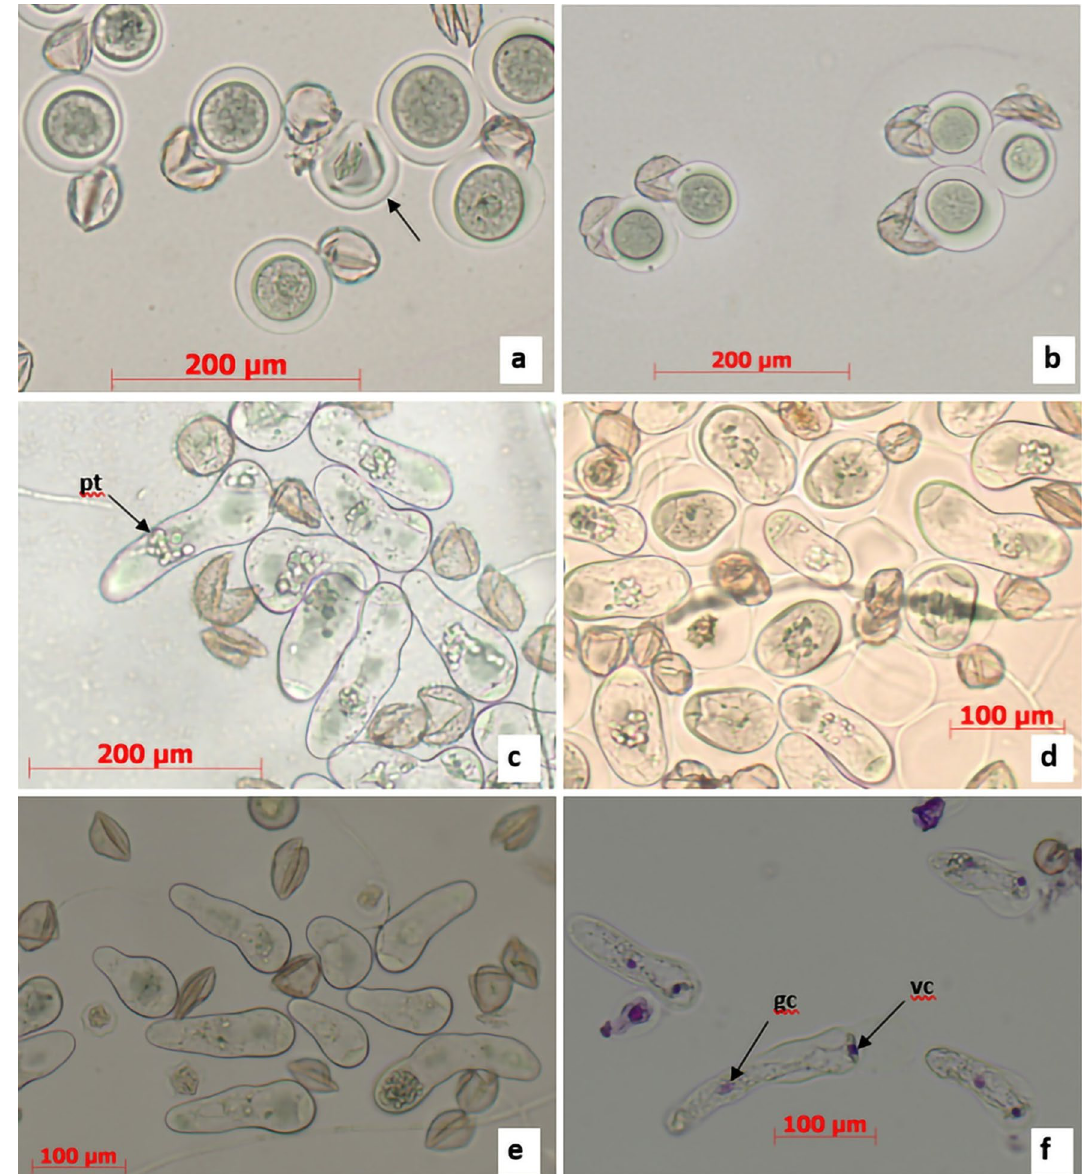
Figure 4. Dynamics of pollen germination showing pollen tube initiation ( a ), persisting hydrophilic capsules of pollen ( b ), and early ( c , d ) and advanced stages of pollen germination ( e , f ); pt pollen tube, gc generative cell, vc vegetative